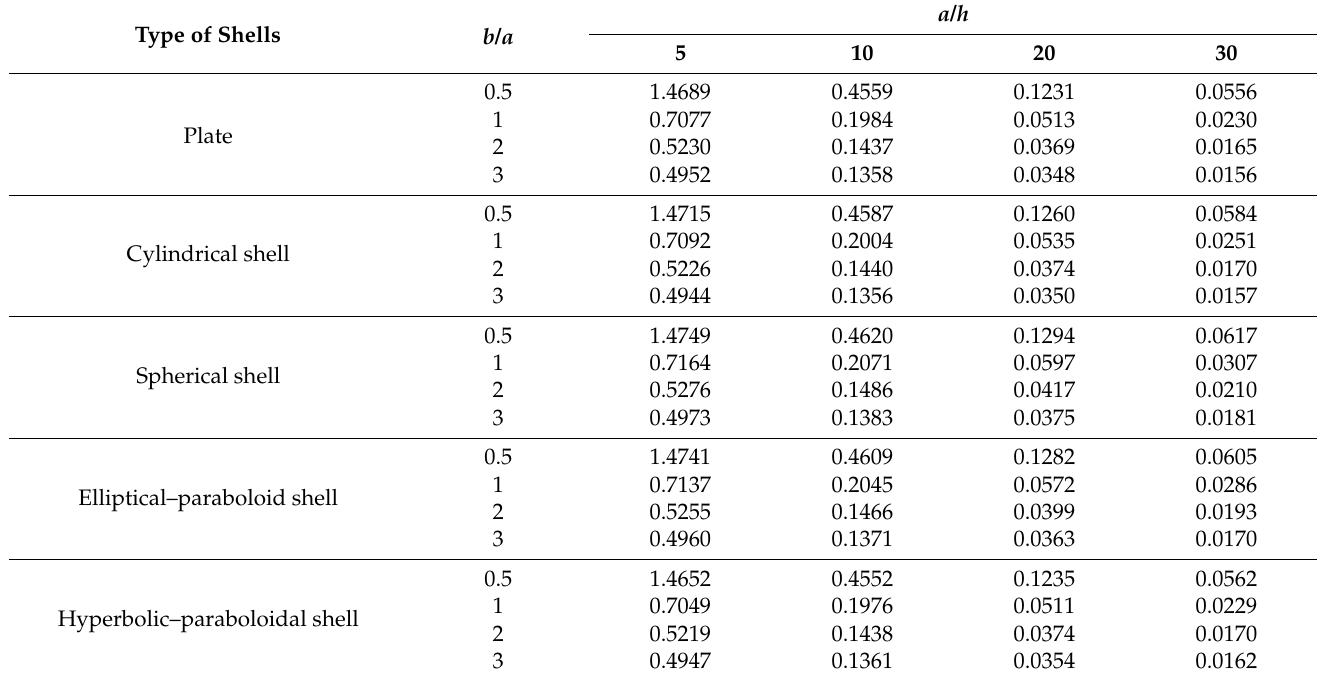
Table 10. The effect of geometric parameters a / h and b / a on the dimensionless frequency of cross-ply